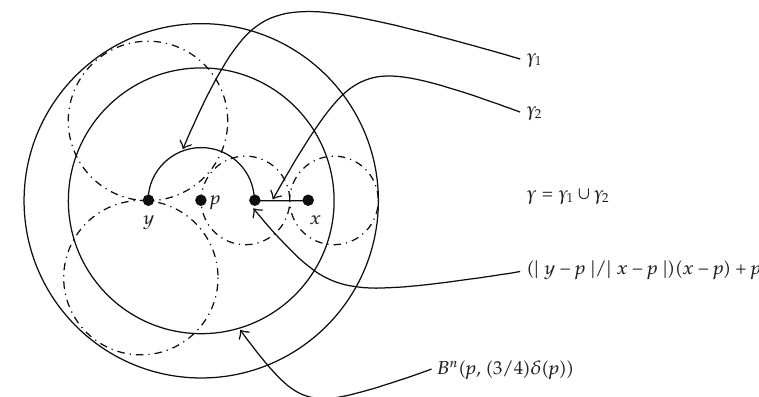
Figure 3: A short path γ (cid:7) γ 1 ∪ γ 2 connecting x and y in B n (cid:5) p, (cid:5) 3 / 4 (cid:6) σ (cid:5) p (cid:6)(cid:6)